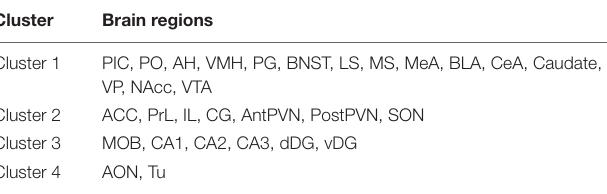
TABLE 3 | Factor analysis results following application of principal axis factoring to saline-treated animals (collapsed across task), identifying four clusters of brain